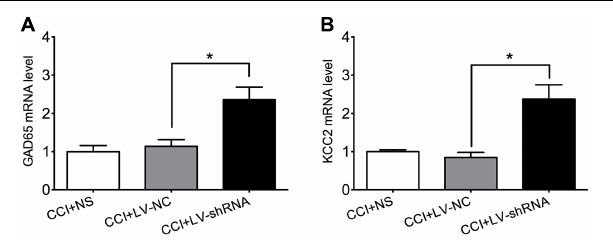
FIGURE 6 | Knockdown of HDAC2 upregulated GAD65 (A) and KCC2 (B) mRNA in the lumbar spinal cord of CCI rats. ∗ p < 0.05, CCI+LV-shRNA vs.